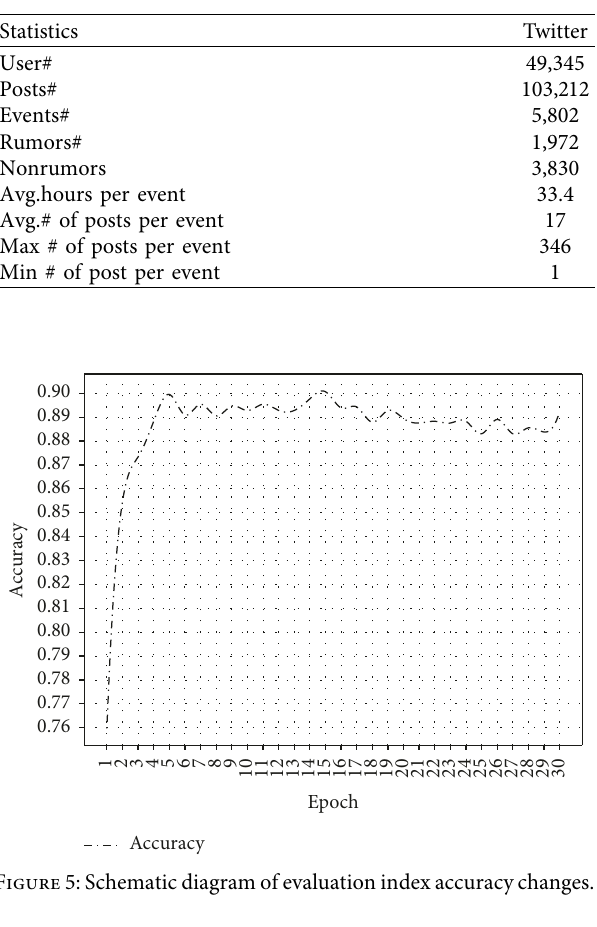
Table 2: Data information of Twitter.